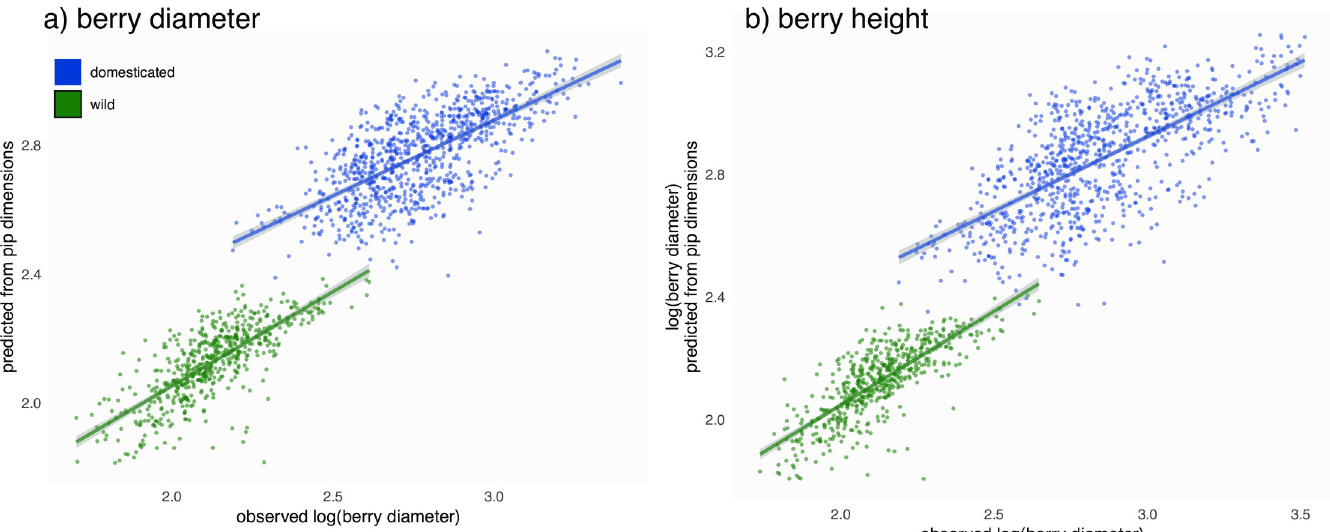
PLOS ONE | https://doi.org/10.1371/journal.pone.0239863 November6,